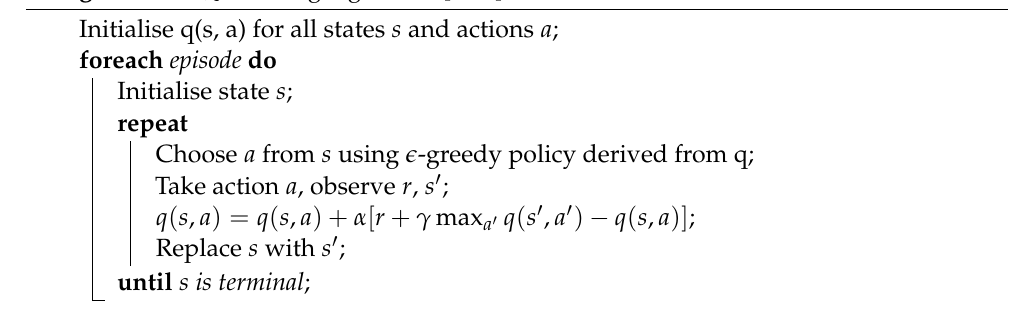
Algorithm 1: Q -learning algorithm